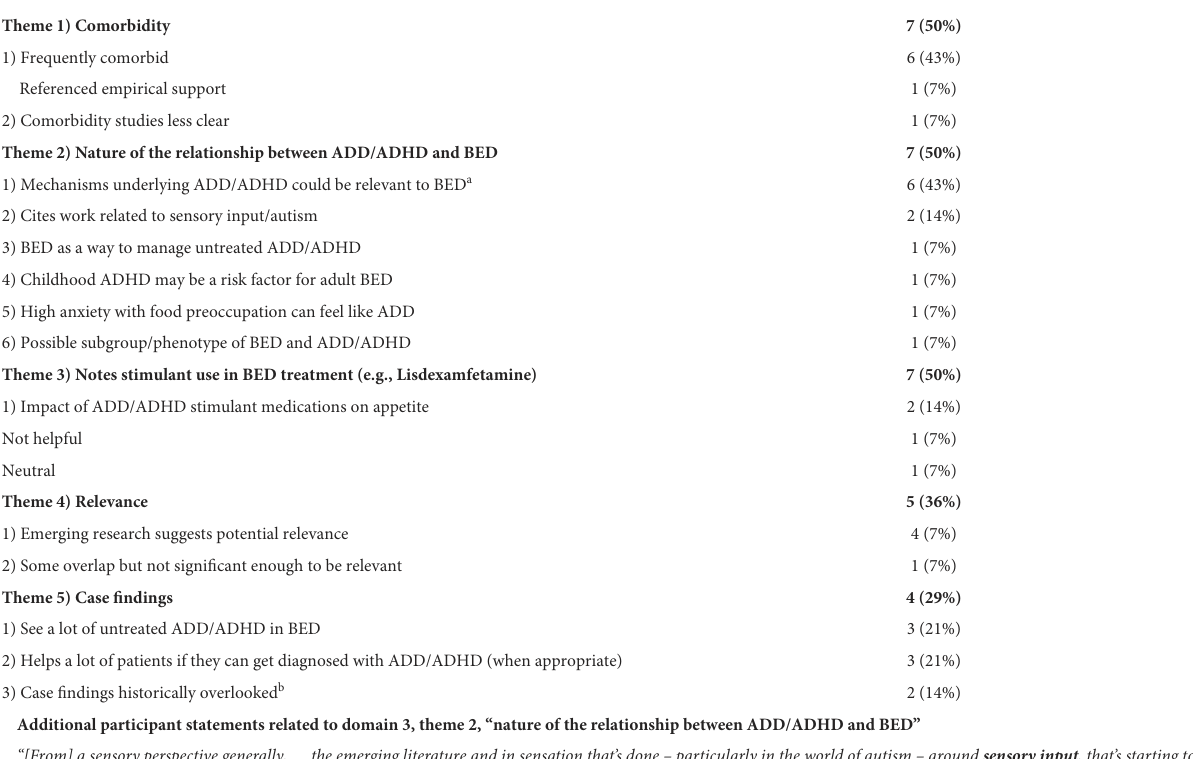
TABLE 6 Participant statements relating domain 3, “ADD/ADHD”